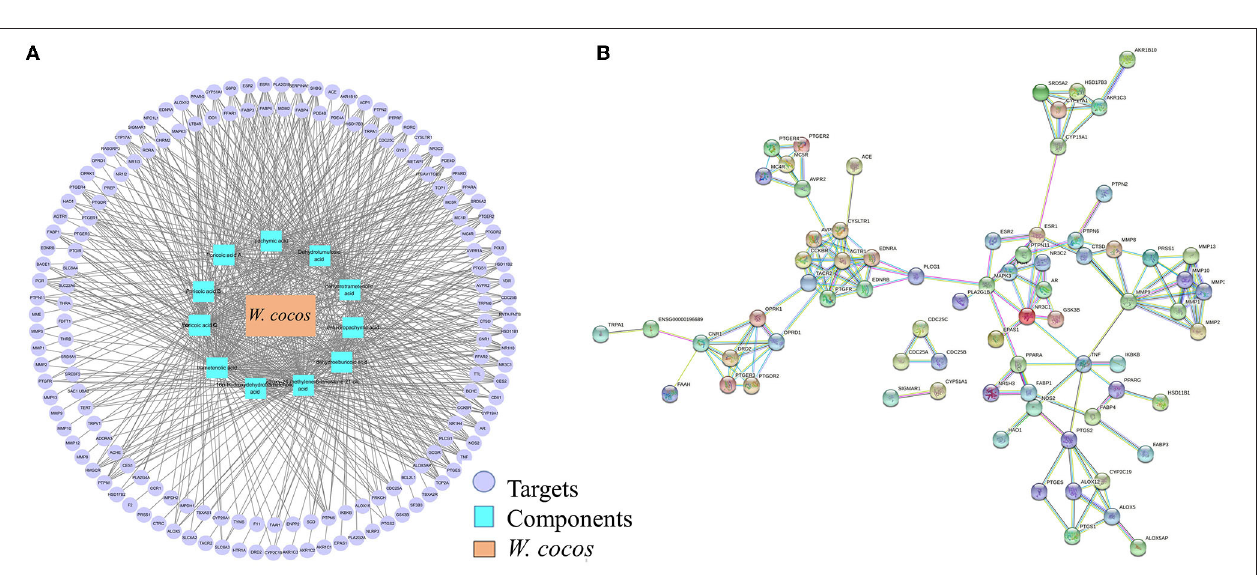
FIGURE 7 | A network pharmacology chart. (A) “Active ingredient-target” Network; (B) PPI